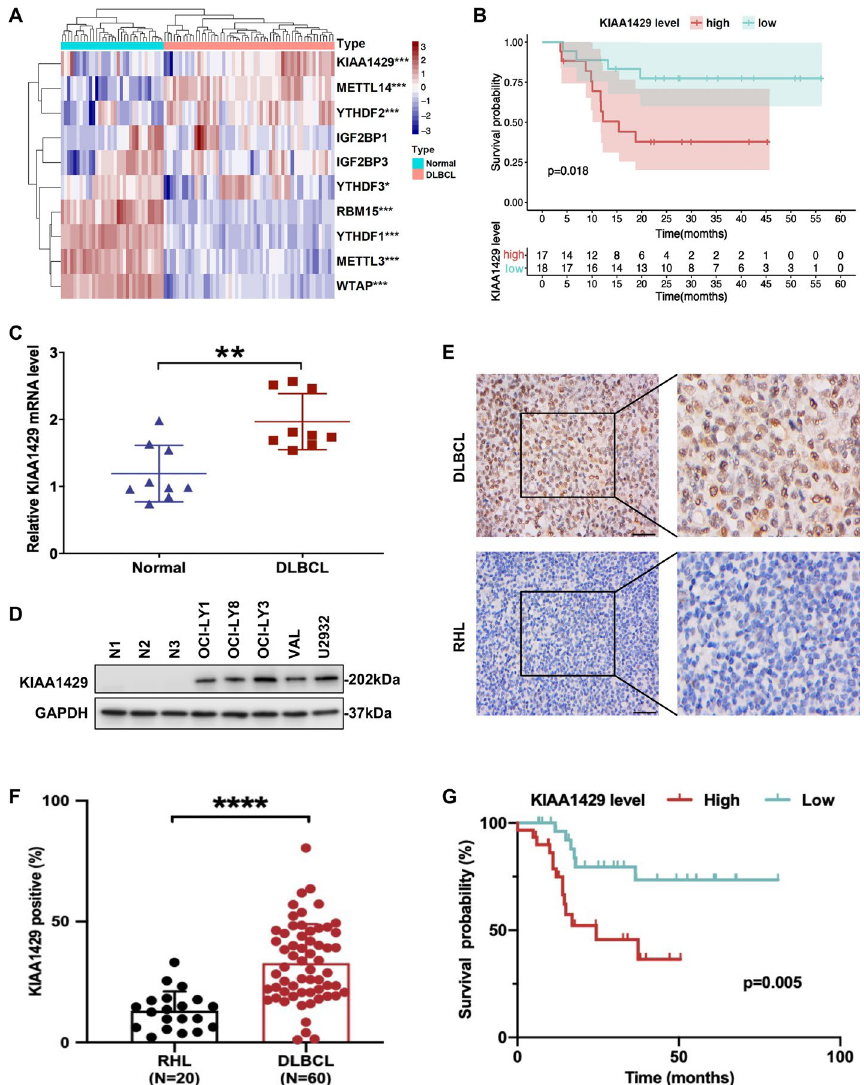
Fig. 1 Dysregulated expression of m6A regulators and elevated KIAA1429 levels were correlated with disease progression in DLBCL. A Heatmap of m6A regulator expression in the healthy tonsil tissues ( n 33) and = DLBCL tissues ( n 55) from the GEO database (GSE56315), with high and low expression levels shown in red = and blue, respectively. B Survival curves indicated shorter survival times for patients with DHL with higher KIAA1429 expression. C The mRNA level of KIAA1429 in DLBCL cells ( n 3) was increased compared with that = in CD19 + B cells ( n 3) as determined by RT-qPCR. Data are represented as mean SD of three independent = ± experiments. ** p < 0.01. D Western blotting indicated enhanced KIAA1429 expression in DLBCL cell lines. E Higher expression of KIAA1429 was found in DLBCL tissues ( n 60) than in RHL samples ( n 20). Bar, = = 50 μm. F Comparison of MOD values for KIAA1429-positive staining in DLBCL and RHL patients by two-tailed Student’s t -test. **** p < 0.0001. G Survival analysis revealed more prolonged survival times of patients with DLBCL with decreased KIAA1429 expression than those with increased KIAA1429 expression. The median overall survival was assessed by the log-rank